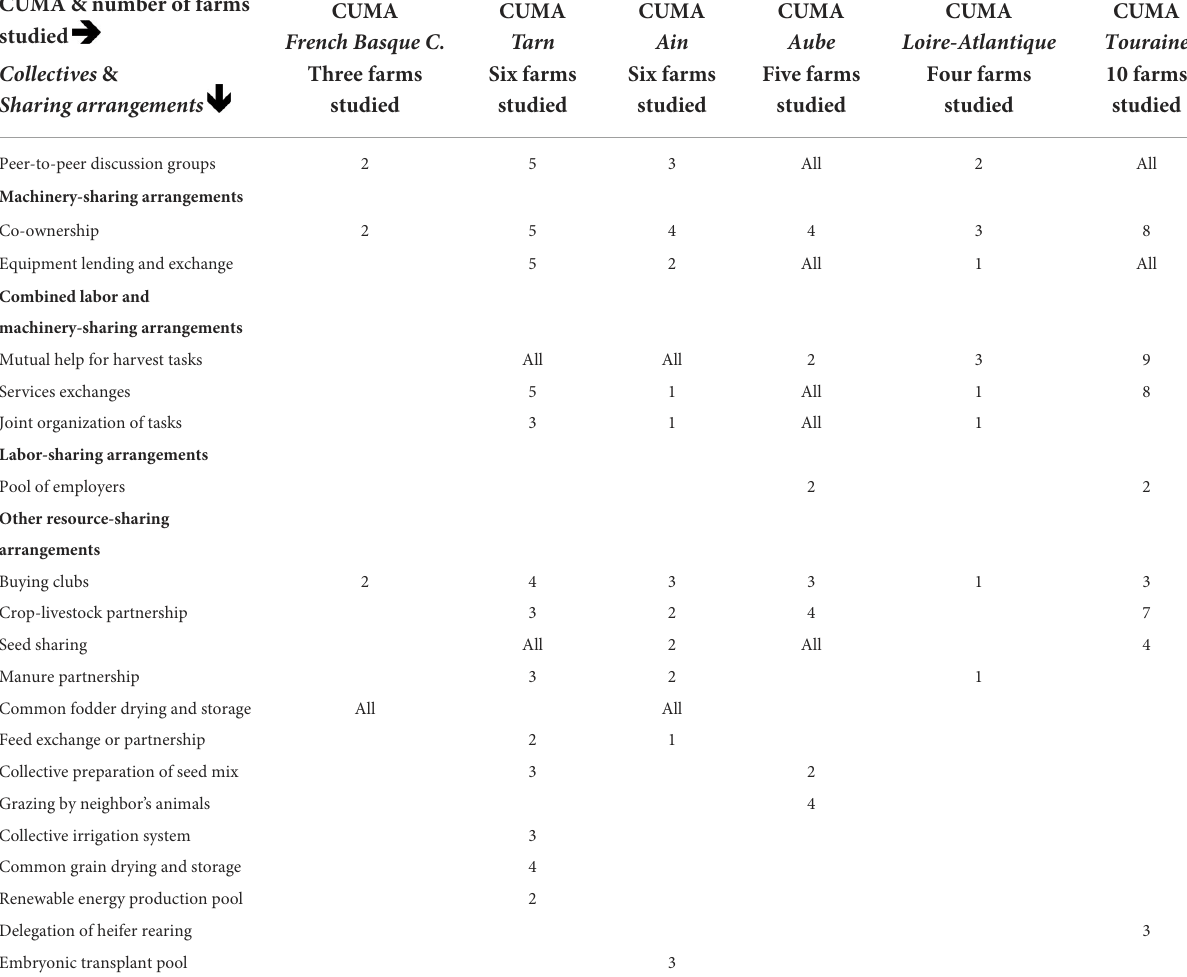
TABLE 2 Number of farmers involved in discussion groups and sharing arrangements in the case studies. CUMA & number of farms